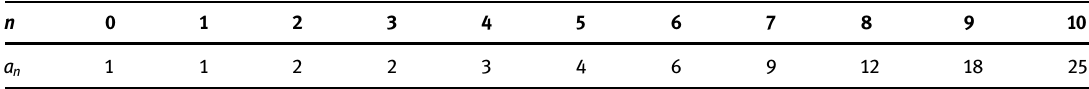
Table 3: The fi rst few values of a n up to = n